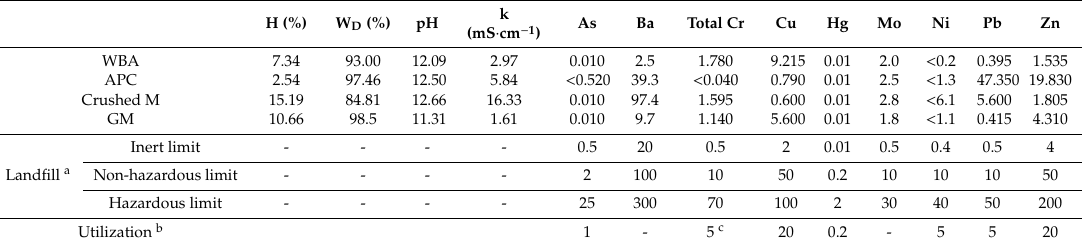
Table 3. Results of humidity (H, %), dried weight (W D , %), pH, k (mS · cm − 1 ) and heavy metal(loid)s concentrations (mg · kg − 1 ) for the WBA, APC, crushed M and GM.